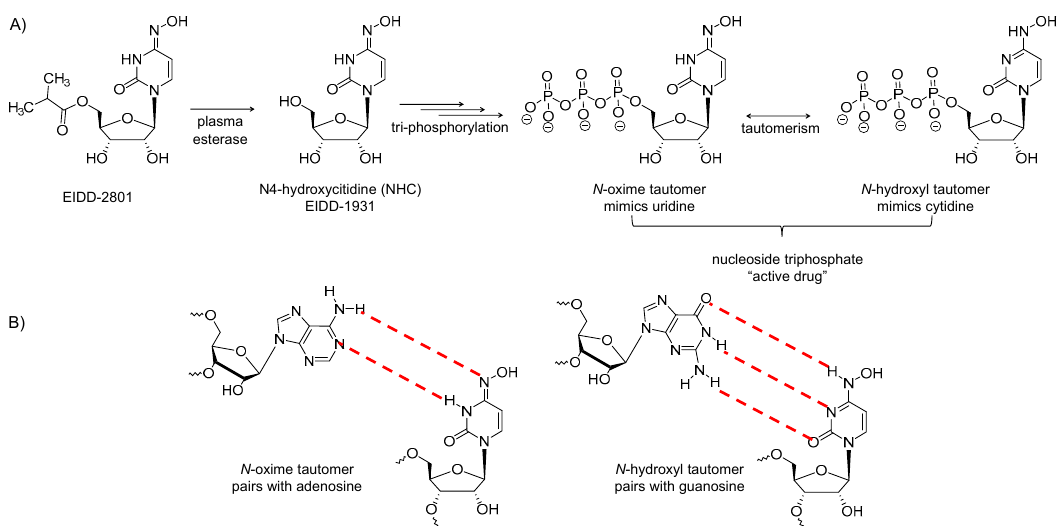
Figure 5. ( A ) Chemical structure of EIDD-2801, an isopropyl ester prodrug of ribonucleoside analog of β -D-N 4 -hydroxycytidine. EIDD-2801 is an orally bioavailable nucleoside derivative that is under development for SARS-CoV-2. Also depicted is its activation to the corresponding tri-phosphorylated form which exhibits a broad-spectrum antiviral activity against various RNA viruses, including coronaviruses with resistance mutations to remdesivir. ( B ) The active form exists in two forms: the oxime form which mimics uridine and pairs with adenosine, while the other tautomer mimics cytidine and pairs with guanosine. The drug eventually leads to a viral error catastrophe.